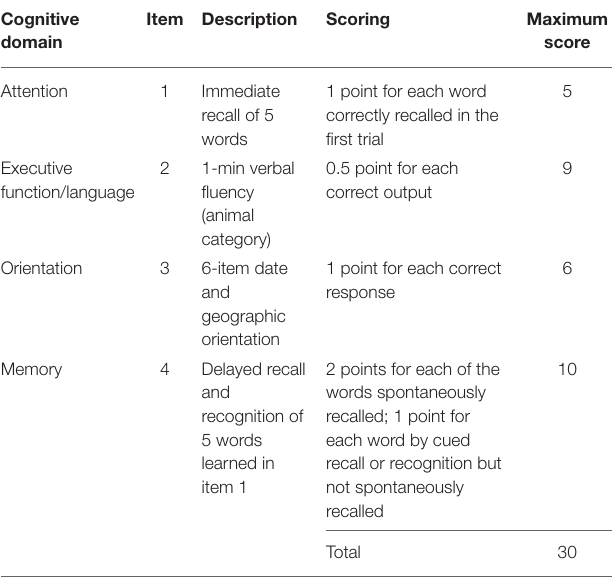
TABLE 1 | Description of MoCA 5-min